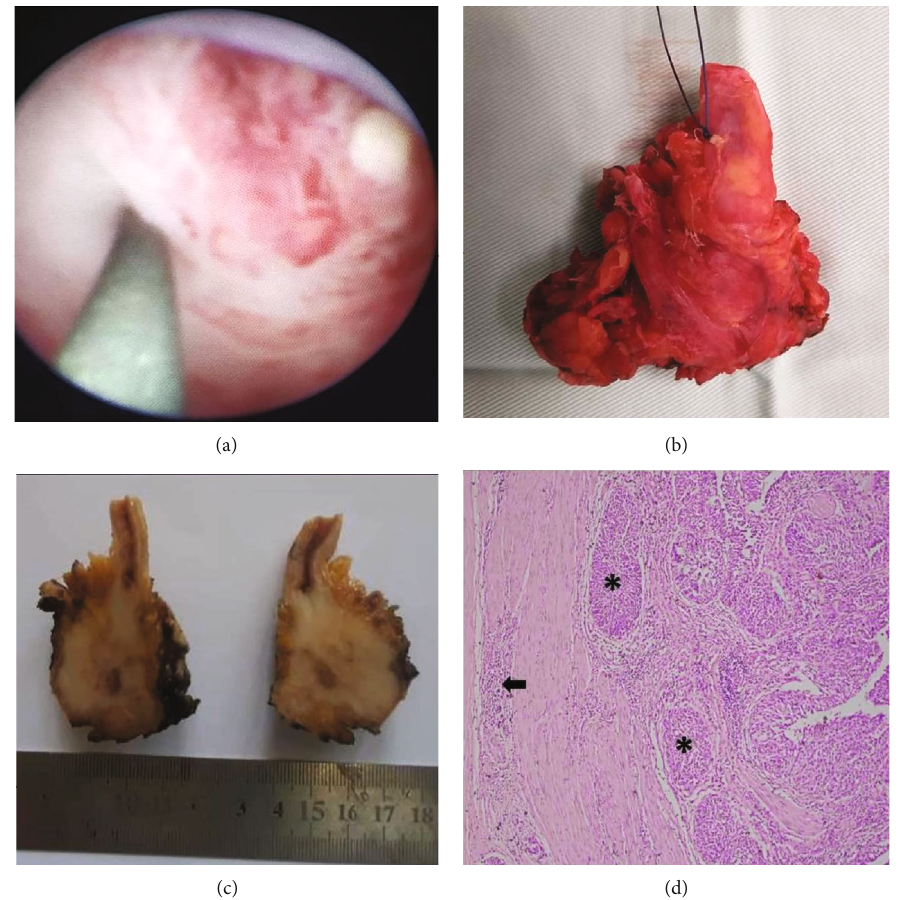
Figure 2: Right ureteric tumour. (a) Ureteroscopic view of the tumour completely obstructing the lumen of the ureter. (b) Macroscopic view of the separately resected tumour with a bladder cu ff . (c) Cut surface appearance of the tumour. (d) × 10 view illustrating the nests of malignant ( ∗ ) cells invading the muscularis propria of the ureter